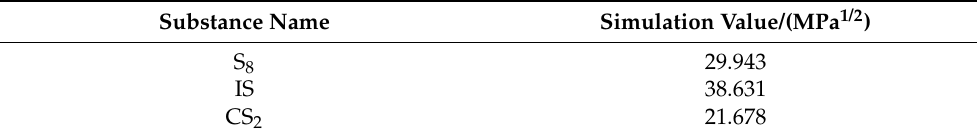
Table 2. Solubility parameter simulation value of S 8 and IS (P 0 = l atm, 333